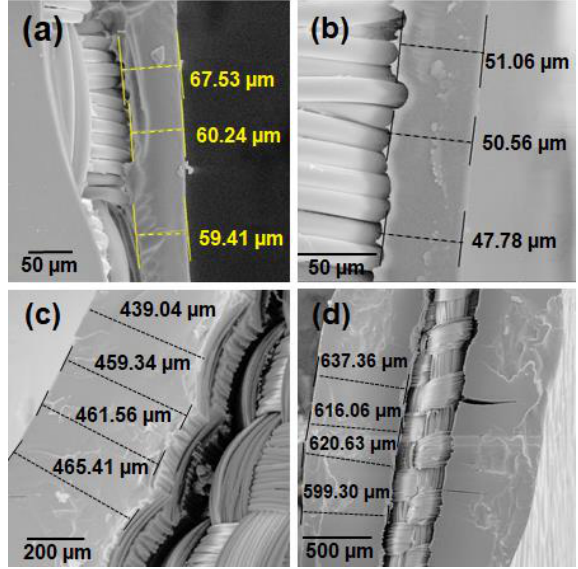
Figure 6. SEM images of ( a ) UV PET 100:0:0.5 , ( b ) UV PET 95:5:0.5 , ( c ) γ60 PET 100:0:50 , and ( d ) γ60 PET 90:10:30 . Diameters of individual fabric fibers were also measured obtaining mean thickness of roughly 15.0 μm for pristine fibers and of 15.2 μm and 15.0 μm for sa mples modified by UV method with PHEMA and poly(HEMA- co-PEGMA) (95:5%) respectively (Figure 7), these constant diameters indicated that there was only a surface grafting of the hydrogel. On the other side, by gamma irradiation, an increase in thickness of fibers was observed; for example, the single fibers of the PET sample grafted with PHEMA had diameters around 21 μm; these results indicated that grafting was also performed inside of the fibers [41]. Also, a clear change on fabric fibers surface was observed (Figure 7e) when gamma irradiation was used.